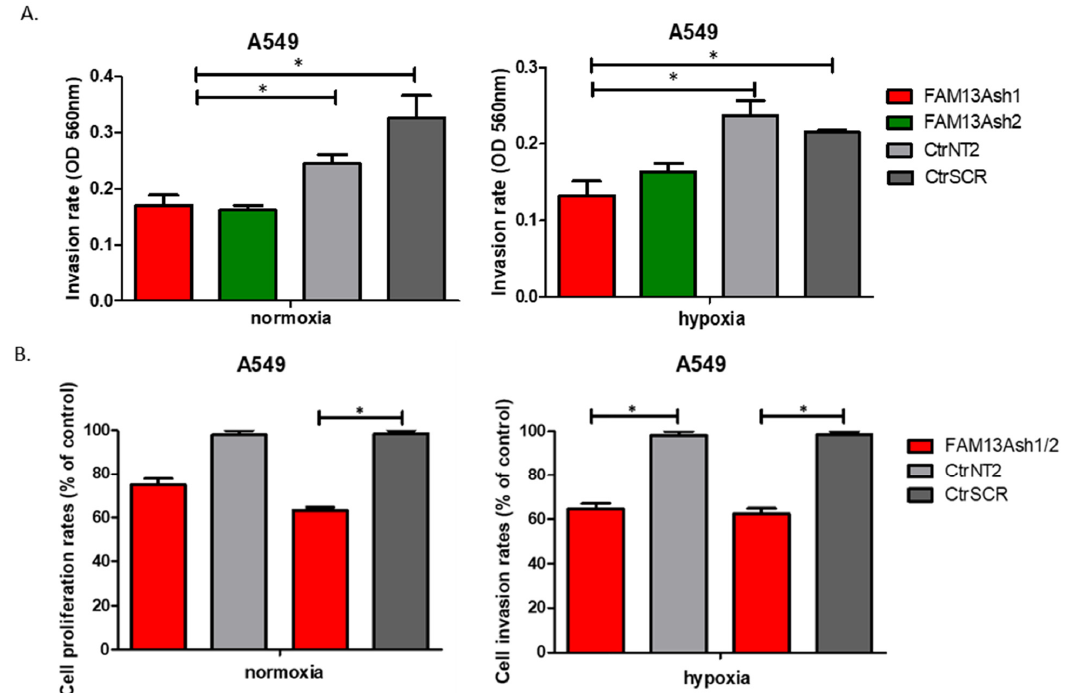
Figure 5. FAM13A knockdown inhibits invasion of A549 lung cancer cells. The influence of FAM13A silencing on the invasive properties of A549 cells was analyzed by the transwell invasion assay. Amount of A549 invasive cells were quantified using a colorimetric method (OD 560 nm) after 48 h of culture in normoxia and hypoxia. ( A ) OD values of invasive A549 FAM13Ash1 (red), FAM13Ash2 (green) cells were decreased remarkably compared with control CtrNT2 (light grey), CtrSCR (dark grey) cells, cultured under normoxia ( left panel) and hypoxia ( right panel). Data is expressed as the mean ± SEM of n = 3 exp., student’s t -test (two-tailed), * p < 0.05. ( B ) Averages of invasion rates are presented for A549 FAM13Ash1 and FAM13Ash2 (red), cells measured as percent of control CtrNT2 (light grey), CtrSCR (dark grey) cells, cultured under normoxia ( left panel) and hypoxia ( right panel). Data is expressed as the mean ± SEM of n = 3 exp., student’s t -test (two-tailed), * p < 0.05.